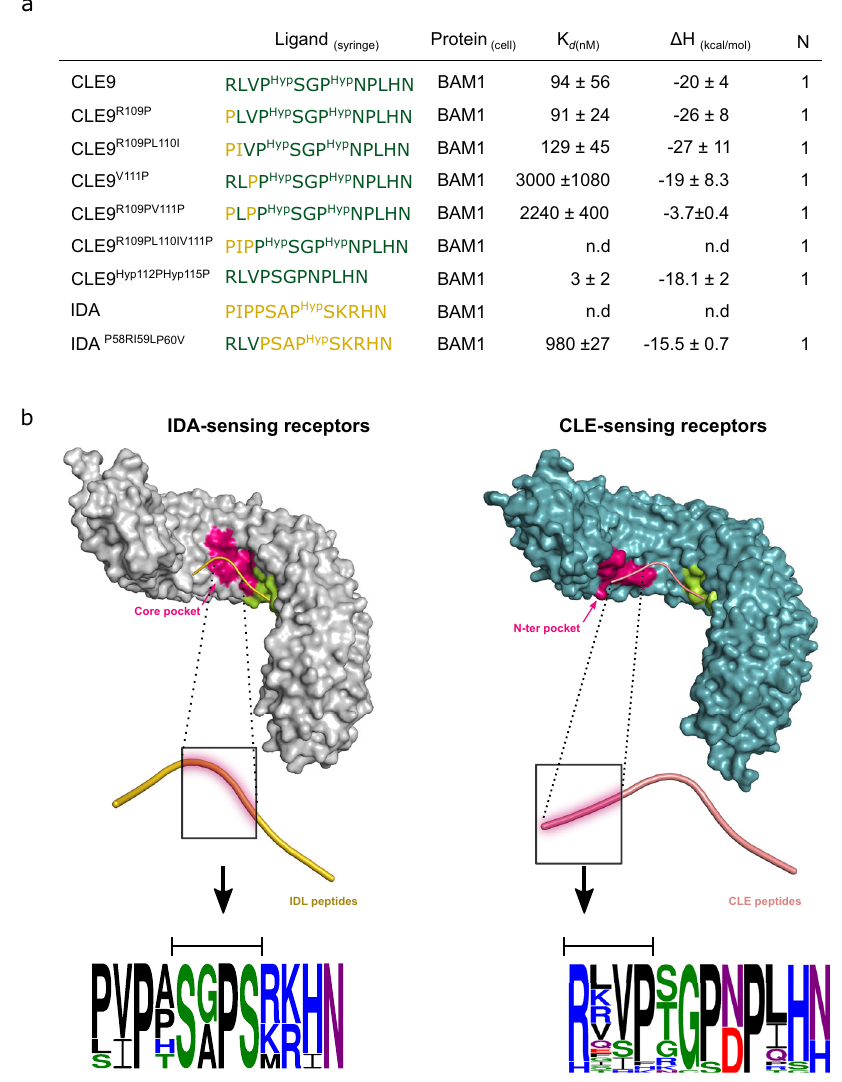
Fig. 3 The CLE9 peptide uses its N-terminal region to speci fi cally anchor to its cognate receptor BAM1. N-terminal engineered CLE9 peptides lose their capacity to bind the BAM1 LRR ectodomain a ITC table summaries of engineered CLE9 and IDA variants versus BAM1. K d , dissociation constant; N, stoichiometry ( n = 1 for a 1:1 interaction). The values indicated in the table are the mean ± SD of at least two independent experiments. b Representation of the speci fi c recognition features of IDA/IDLs and CLE-like peptides by their cognate receptors. IDA/IDL peptides and IDA-like receptors are depicted in gold (cartoon) and gray (surface), respectively. CLE-like peptides and CLE-like receptors are shown in pink (cartoon) and dark cyan (surface), respectively. The receptor region highlighted in magenta depicts unique structural features for peptide recognition in each type of receptors; and illustrates the receptor region where the peptide is highly coordinated to form a high-af fi nity binding pair. We termed these regions “ core pocket ” and “ N-ter pocket ” for the IDA- like and CLE-like receptors, respectively. The surface depicted in light green corresponds to a common receptor architecture, with a similar peptide-binding recognition in both types of receptors. A magni fi cation of the peptides is shown to highlight the amino acid position at the speci fi c receptor pocket. Peptide sequence logos for each peptide family were generated through the WebLogo 3 server (http://weblogo.threeplusone.com/ 70 ) using the sequence information of the IDA/IDL peptides (IDA and IDL1-6) and the mature sequence of the 27 A. thaliana CLE peptides 71 .The size of the amino acid letters correlates with the residue frequency, and the color code depicts the following amino acid properties: green for polar, purple for neutral, blue for basic, red for acidic and black for hydrophobic